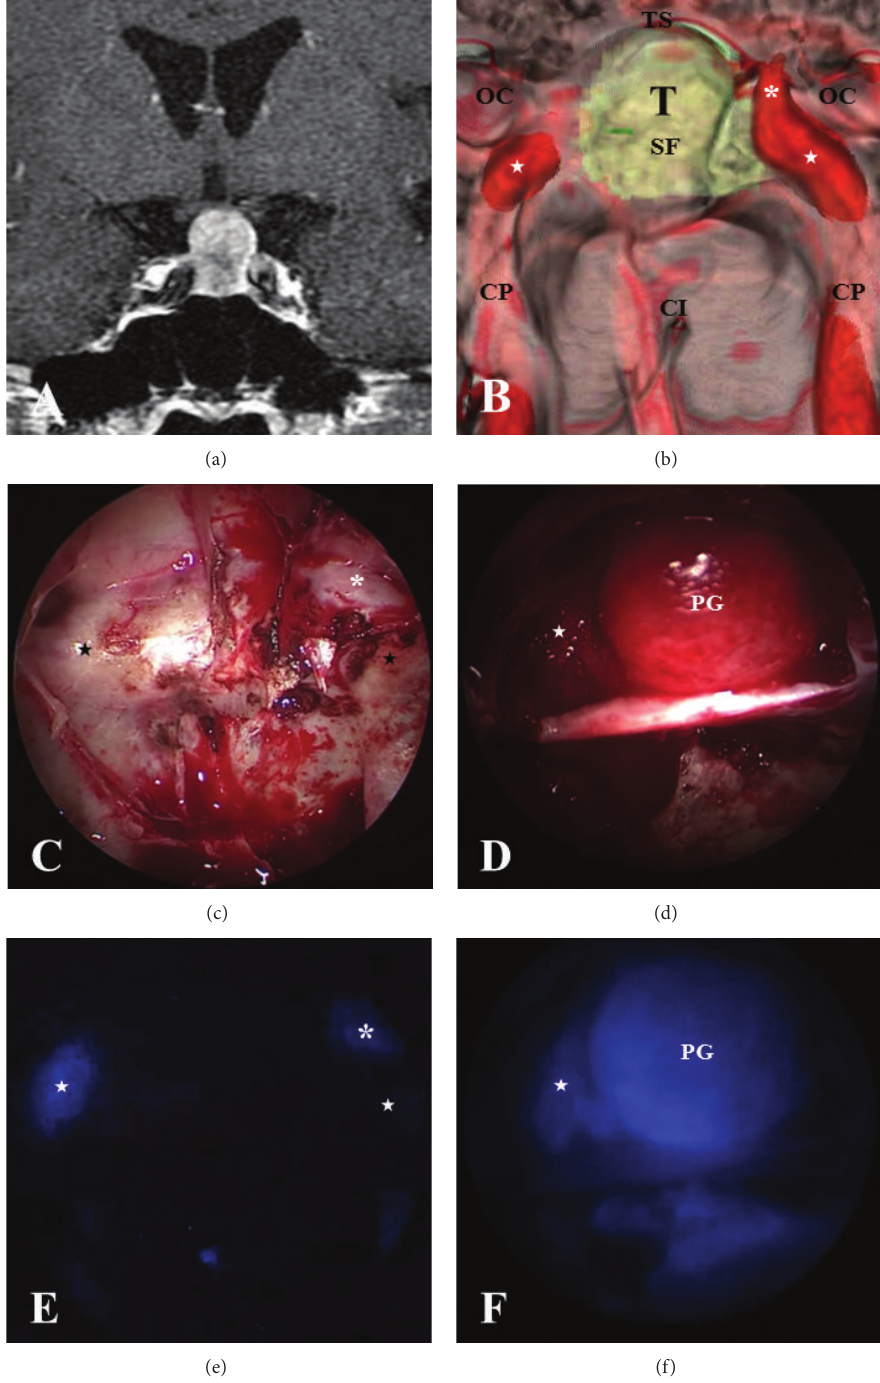
Figure 1: An illustrative case showing images of a fusion model of 3D-CT and MRI and intraoperative ICG endoscopy along with the corresponding endoscopic views. (a) Gadolinium- (Gd-) enhanced magnetic resonance imaging (MRI) showing a pituitary adenoma with suprasellar extension (coronal section). (b) Preoperative simulated view of the endoscopic endonasal transsphenoidal approach produced by the fusion model of 3D-CT and MRI that show bony prominences of the internal carotid arteries (ICAs), optic canals, and pituitary tumor around the sellar floor. (c) Intraoperative endoscopic view showing bony structures around the sellar floor (unopened). (d) Intraoperative endoscopic view showing the intrasellar structures, mainly the descending diaphragma sellae (DS) with the normal pituitary gland after total resection of the tumor. (e) Indocyanine green (ICG) endoscope showing vital structures such as the ICAs (a view corresponding to (c)) and (f) ICG endoscope showing ICAs in the right cavernous sinus and a normal pituitary gland adhered to the DS (SF: sellar floor; TS: tuberculum sella; CI: clival indentation; CP: ICA prominence; stars: C4 portion of ICA; asterisks: C3 portion in the cavernous sinus; OC: optic canal; and T: tumor). (e) Before opening the sella; (f) after tumor